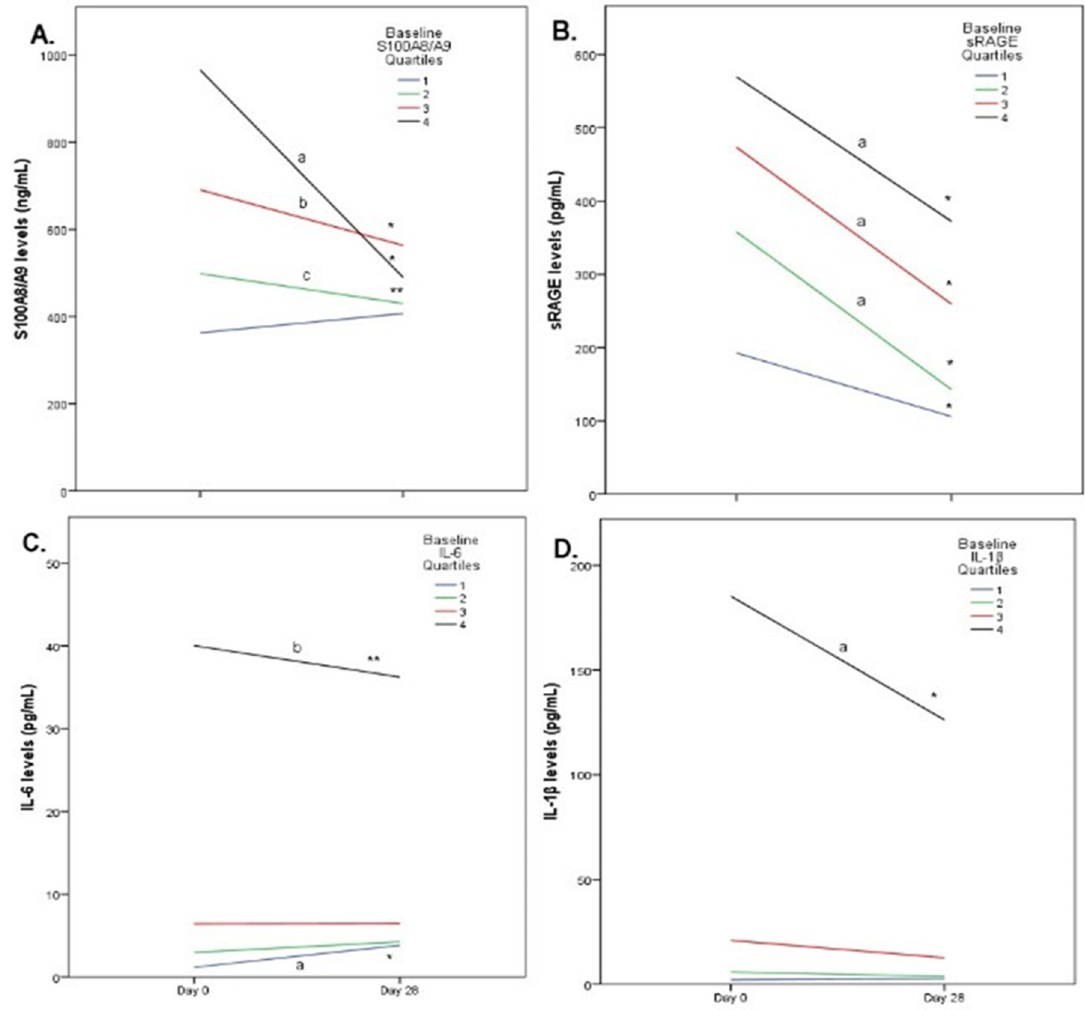
Figure 4. Line charts with biomarkers’ changes according to baseline values for S100A8/A9. ( A ), * p < 0.001 vs. baseline, ** p < 0.01 vs. baseline, a p < 0.001 vs. 1st, 2nd and 3rd quartile, b p < 0.001 vs. 1st quartile, c p < 0.01 vs. 1st quartile; sRAGE ( B ), * p < 0.001 vs. baseline, a p < 0.001 vs.1st quartile; IL-6 ( C ) * p < 0.001 vs. baseline,** p < 0.05 vs. baseline, a p < 0.001 vs. 3rd and 4th quartile, p < 0.05 vs. 2nd quartile, b p < 0.001 vs. 2nd quartile, p < 0.05 vs. 3rd quartile; IL-1 β ( D ), * p < 0.001 vs. baseline, a p < 0.001 vs. 1st, 2nd and 3rd quartile.